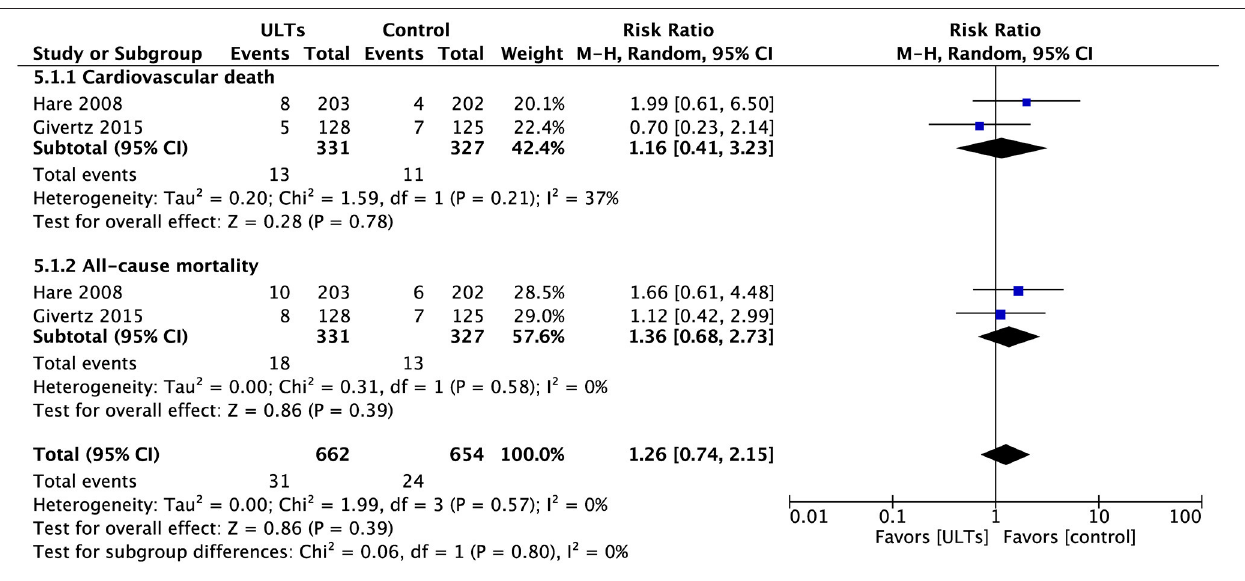
FIGURE 10 | Meta-analysis of all-cause mortality and cardiovascular